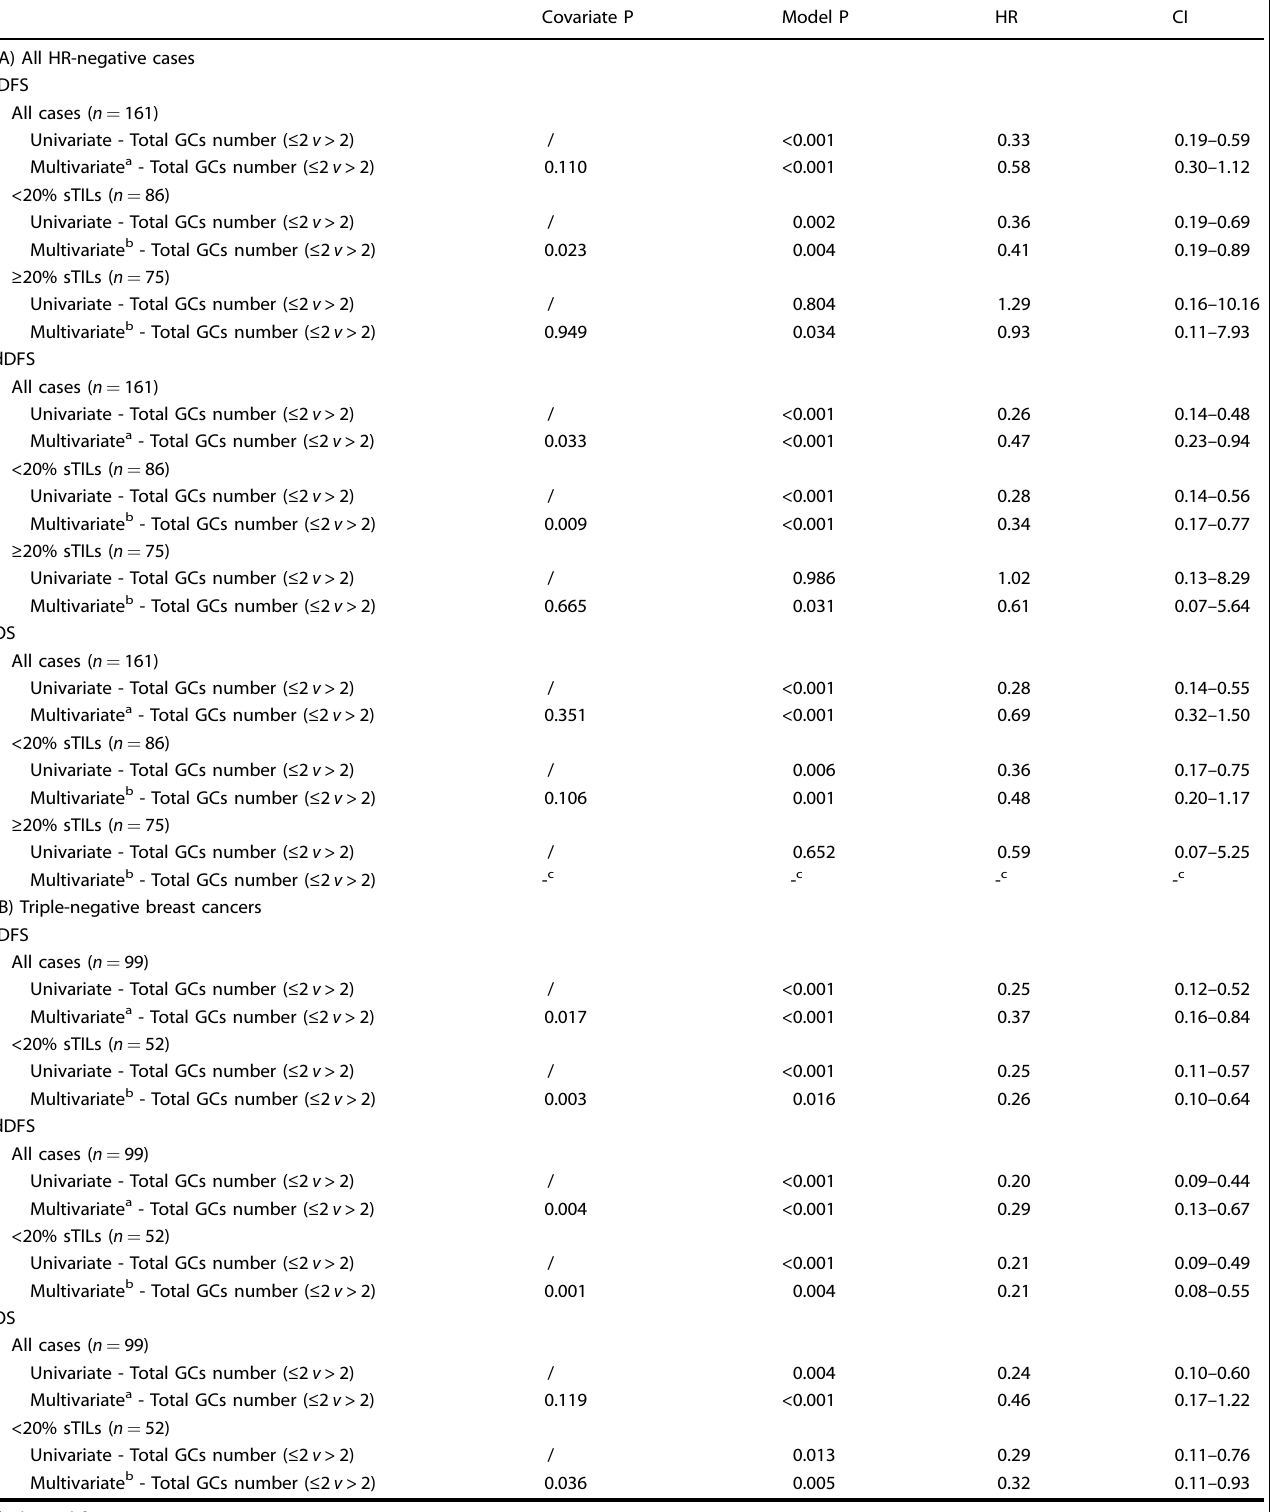
Table 3. Univariate and multivariate Cox regression analyses of germinal center numbers in cancer-free LNs for iDFS, dDFS, and OS of HR-negative, their TILs subgroups, all TNBC and low TILs TNBC. Covariate P Model P HR